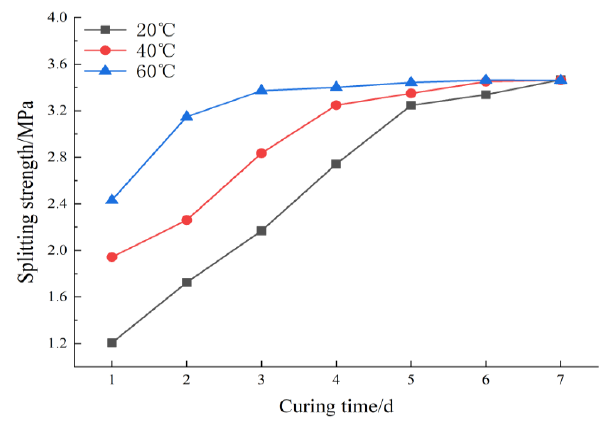
Figure 7. Spli tt ing strength at di ff erent curing temperatures. Figure 7. Splitting strength at different curing